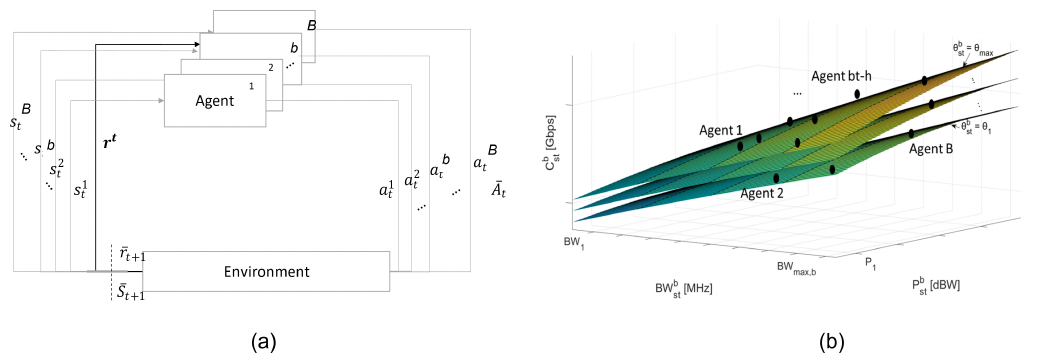
Figure 7. Multi-gent approach (B Agents). ( a ) The RRM problem for multibeam systems is defined as a MDP with a multiagent environment that works cooperatively to achieve maximum reward. ( b ) There are B agents sharing the same space of possible resource allocation, each agent manages the power, beamwidth, and bandwidth in each